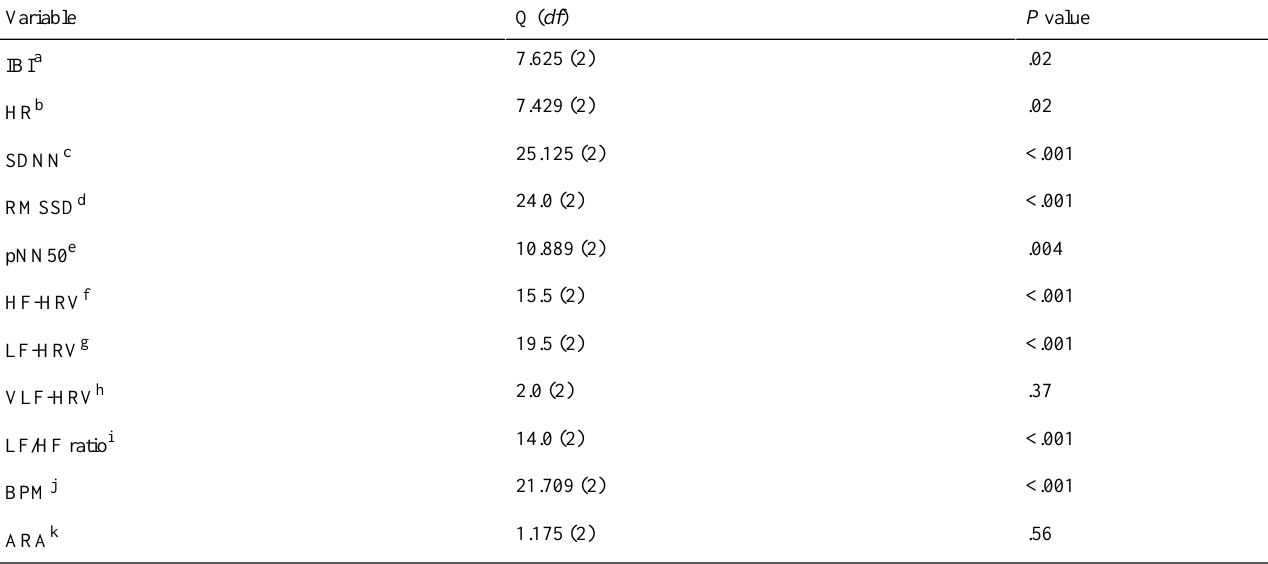
Table 2. Omnibus tests (Friedman) of within-subject